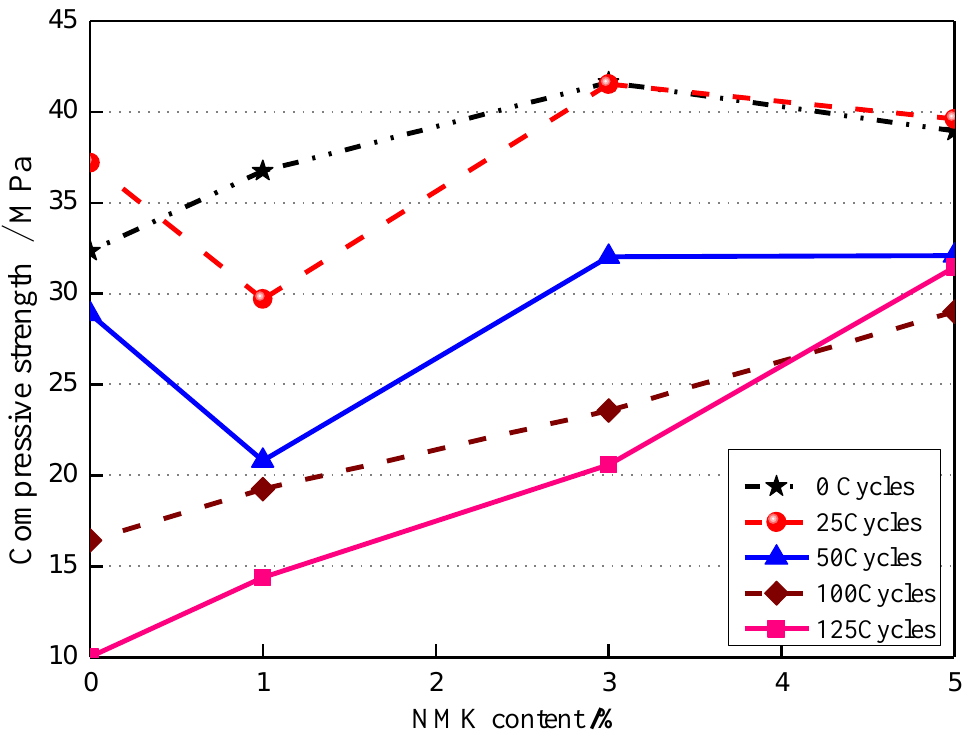
Figure 8. Relationship between compressive strength and NMK additions for concrete under freeze – thaw cycles. thaw